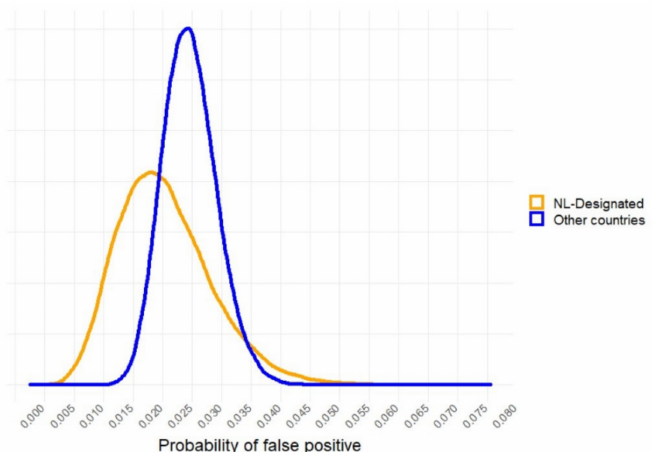
Figure 1. Uncertainty density distribution for the probability of false positive given a misclassification of a negative Salmonella sample at the laboratory, based on the results of the Salmonella